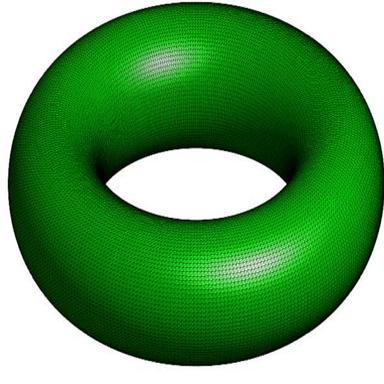
Analysed torus.